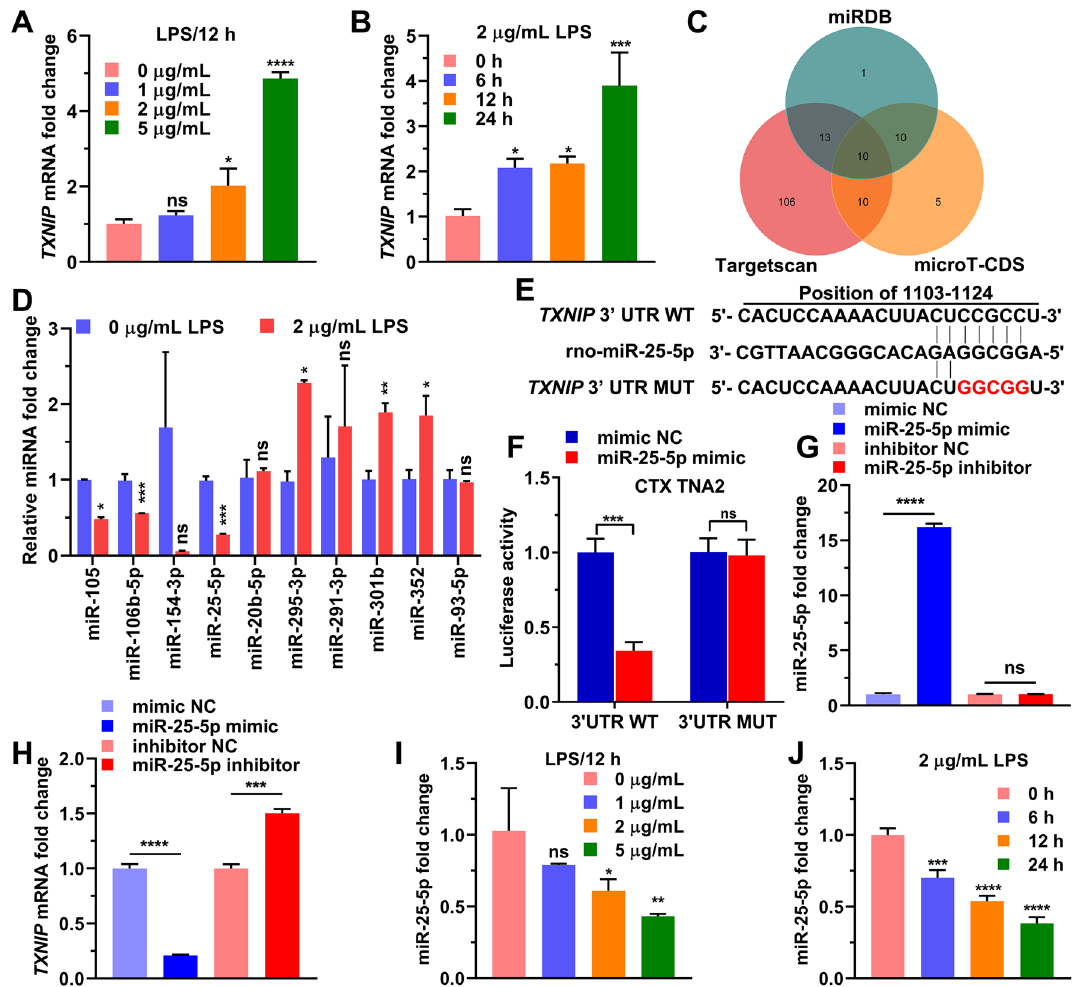
Figure 1. miR-25-5p negatively regulates TXNIP expression. ( A ) TXNIP fold change of CTX TNA2 cells in response to 0 μg/mL, 1 μg/mL, 2 μg/mL, and 5 μg/mL LPS stimulation over 12 h. ( B ) TXNIP fold change of CTX TNA2 cells in response to 2 μg/mL LPS stimulation over 0 h, 6 h, 12 h, and 24 h. ( C ) Numbers of miRNAs predicted to bind to 3 ′ -UTR sequence of TXNIP mRNA from miRDB, microT-CDS, and Targetscan. ( D ) The fold changes of top 10 predicted miRNAs CTX TNA2 cells in response to 2 μg/mL LPS stimulation. ( E ) Sequences of wild-type ( TXNIP 3 ′ UTR WT) and mutant TXNIP 3 ′ -UTR ( TXNIP 3 ′ UTR MUT). ( F ) Luciferase activities of recombined reporter plasmids ( TXNIP 3 ′ UTR WT and TXNIP 3 ′ UTR MUT) co-transfected with miR-25-5p mimic. ( G , H ) miR-25-5p ( G ) and TXNIP ( H ) mRNA fold change of CTX TNA2 cells in response to the transfection of miR-25-5p mimic and miR-25-5p inhibitor. ( I ) miR-25-5p fold change of CTX TNA2 cells in response to 0 μg/mL, 1 μg/mL, 2 μg/mL, and 5 μg/mL LPS stimulation over 12 h. ( J ) miR-25-5p fold change of CTX TNA2 cells in response to 2 μg/mL LPS stimulation over 0 h, 6 h, 12 h, and 24 h. The relative expression levels of miRNA and mRNA were determined by qPCR and protein levels were determined by western blotting. The independent t -test was applied to the comparison between groups ( D , F , G , and H ). One-way analysis of variance (ANOVA), followed by Tukey’s test was used to identify the significant differences among multiple groups ( A , B , I , and J ). Values are shown as the mean ± standard deviation (SD). Con: negative control of LPS, LPS: lipopolysaccharide, mimic NC: negative control of miR-25-5p mimic, inhibitor NC: negative control of miR-25-5p inhibitor. ns indicates not significant. * P < 0.05. ** P < 0.01. *** P < 0.001. **** P < was alleviated by the miR-25-5p mimic for IL-1β ( t = 5.94, P < 0.001), IL-6 ( t = 15.81, P < 0.0001), IL-10 ( t = 5.257, P < 0.01), and TNF-α ( t = 7.73, P < 0.001) (Fig. 3). After rats were treated with LPS or/and AAV-miR-25-5p, the plasma was harvested for ELISA. A significant increase was observed in the concentration of IL-1β ( t = 11.43, P < 0.0001), IL-6 ( t = 14.47, P < 0.0001), IL-10 ( t = 8.15, P < 0.001), and TNF-α ( t = 10.83, P < 0.0001) after LPS injection, which was significantly alleviated by the injection of AAV-miR-25-5p for IL-1β ( t = 6.46, P < 0.001), IL-6 ( t = 5.87, P < 0.01), IL-10 ( t = 5.53, P < 0.01), and TNF-α ( t = 5.13, P < 0.001) (Fig. 4). These findings implied that upregulation of miR-25-5p levels attenuated LPS-induced IL-1β, IL-6, IL-10, and TNF-α.